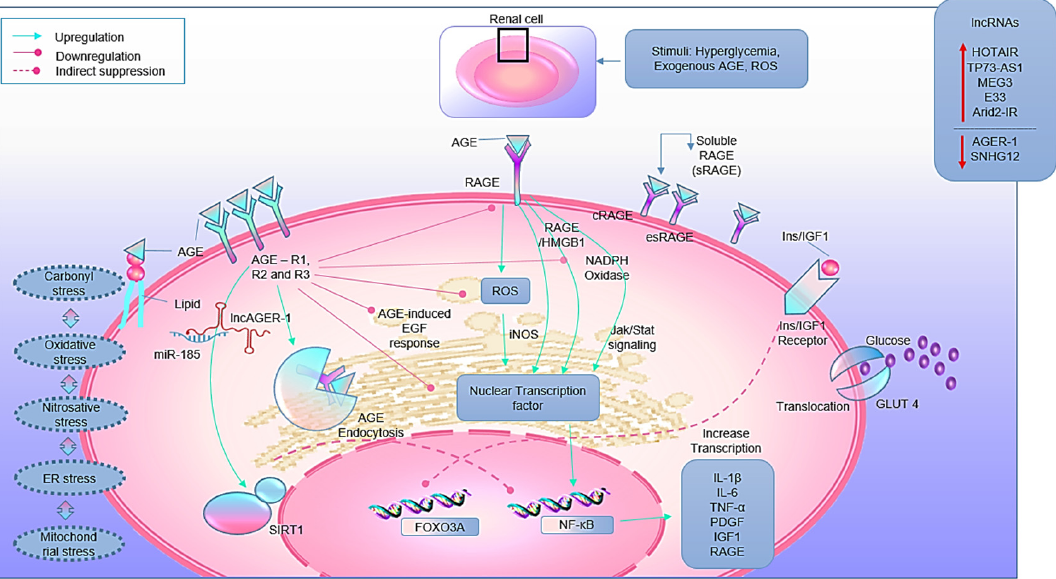
Figure 3. AGEs cellular signaling pathway through its receptors. AGE-RAGE interaction promotes NADPH oxidase and ROS production as well as regulates many downstream signaling pathways. AGER complex helps in the detoxification and degradation of AGEs. Abbreviations: IGF-1, Insulin- like growth factor-1; PDGF, platelet-derived growth factor; ISRE, interferon-stimulated response element; ROS, reactive oxygen species; SIRT1, silent mating type information regulator 2 homolog